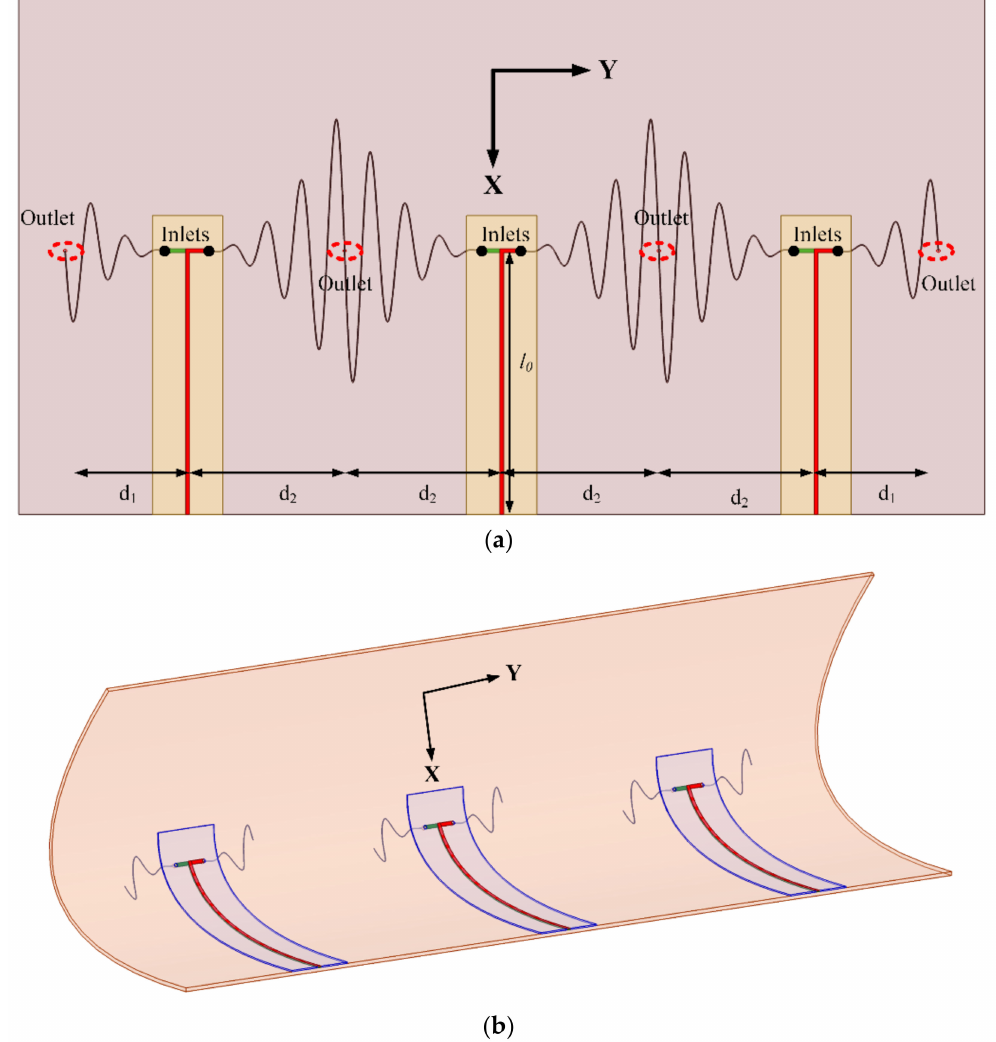
Figure 3. CAD Model of multi-element SEVA-CLA ( a ) Top view: Connection of feed elements with sinusoidally meandered dipoles ( b ) Side view: Connection of feed elements with sinusoidally meandered